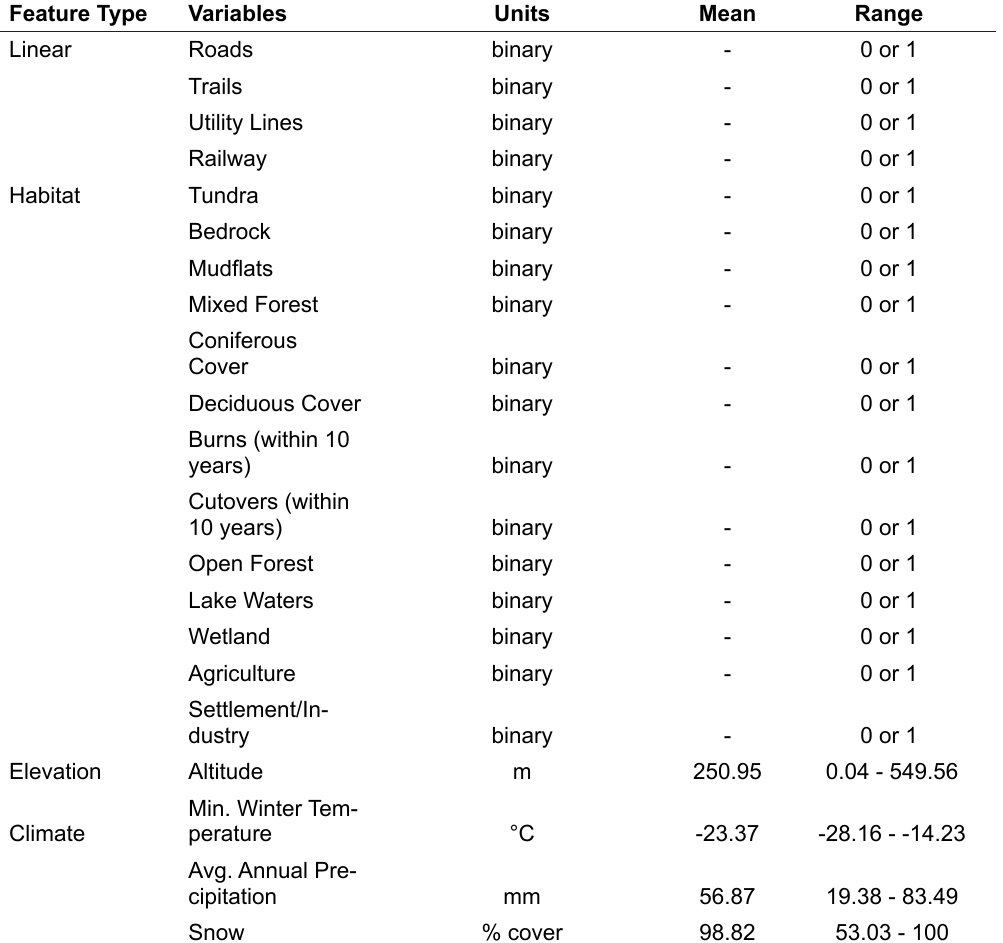
Table S1. Summary of predictor variables used to create caribou occurrence models. The 12 habitat variables were grouped based on their similarities from 26 total habitat